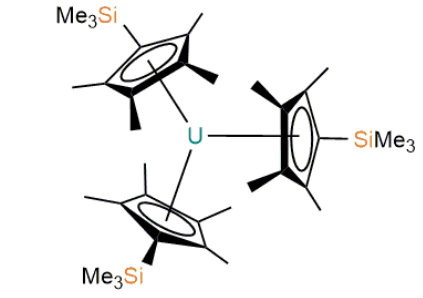
Figure 9. Tris(trimethylsilylcyclopentadienyl)uranium(lll), U(C 5 Me 4 SiMe 3 ) 3 . Table 12. Calculated 29 Si pNMR shifts of U(C 5 Me 5 · SiMe 3 ) 3 in ppm at 298 K. The final, ZFS corrected, computational values are